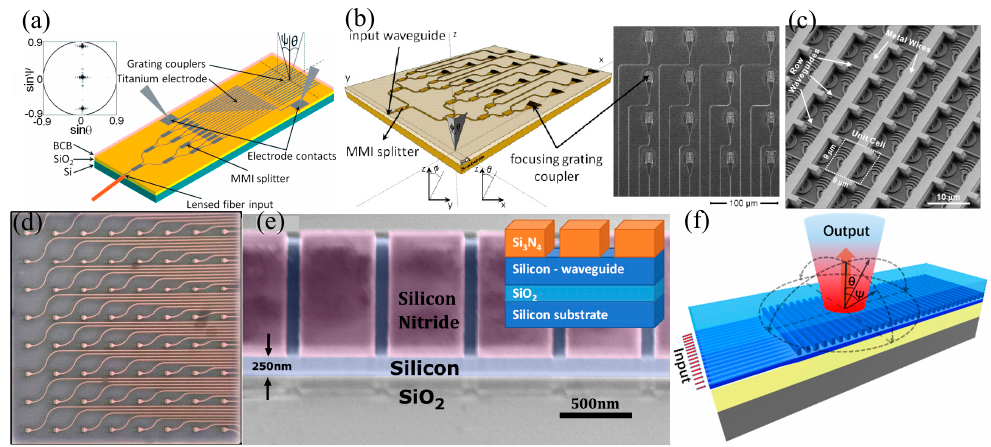
Figure 8. WGA-based OPAs. ( a ) The first OPA introduced in Si photonics. Reprinted with permission from [7] © The Optical Society. ( b ) A 4 × 4 WGA-based OPA. Reprinted with permission from [8] © The Optical Society. ( c ) SEM of a fabricated OPA after dry etching away the dielectric SiO 2 . Reprinted with permission from [87] © The Optical Society. ( d ) An 8 × 8 OPA receiver. Reprinted with permission from [43] © The Optical Society. ( e ) False-colored tilted SEM of an aperiodic Si/Si 3 N 4 grating. Reprinted with permission from [109] © The Optical Society. ( f ) A high contrast WGA-based OPA with high efficiency and low crosstalk. Reprinted with permission from [110] © The Optical Society.